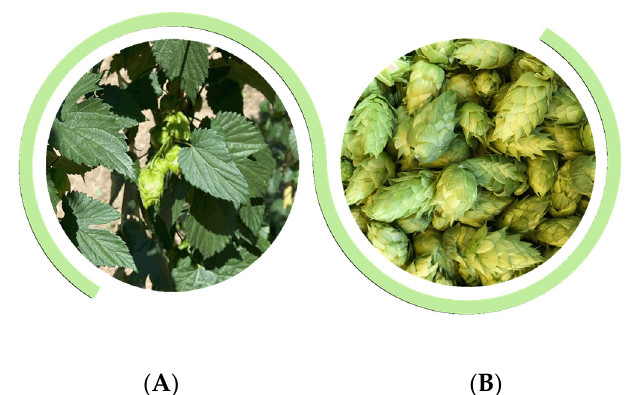
Figure 1. H. lupulus cv. Chinook fresh leaves ( A ) and inflorescences ( B